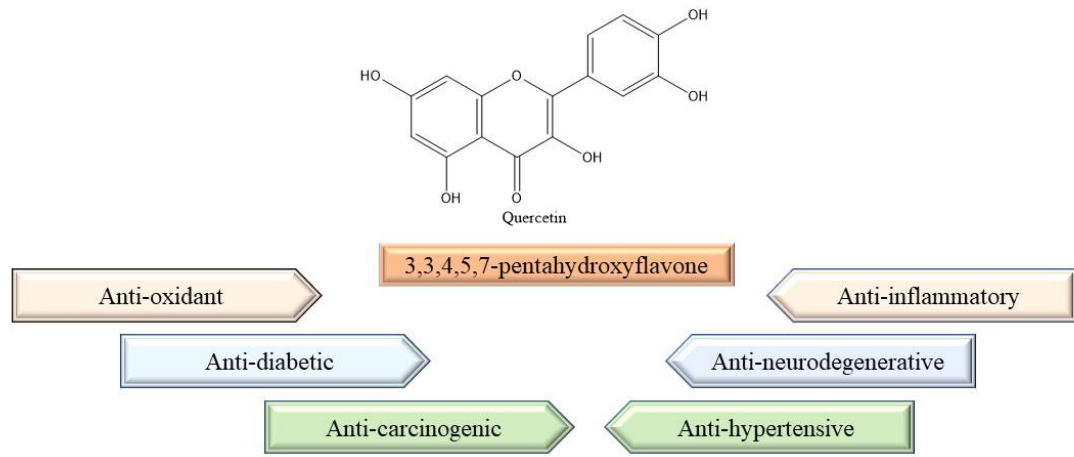
Figure 4. Structure and properties of quercetin.